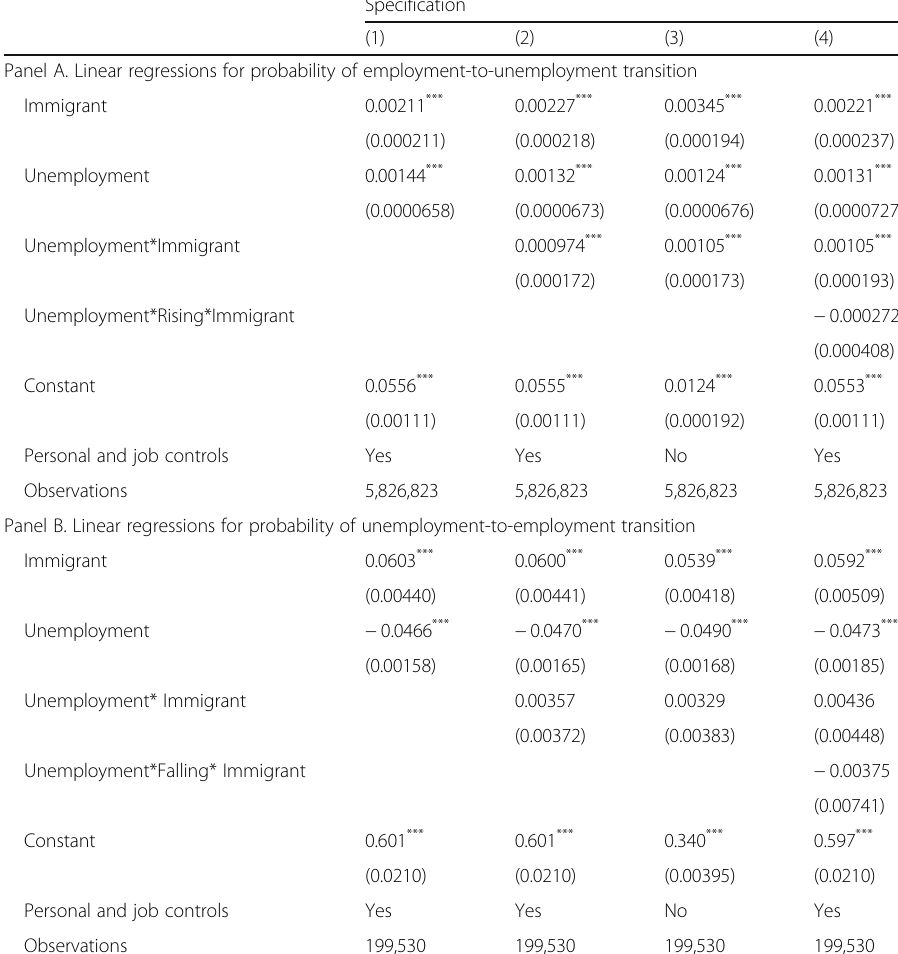
Table 12 Estimated transitions between employment and unemployment: matched CPS